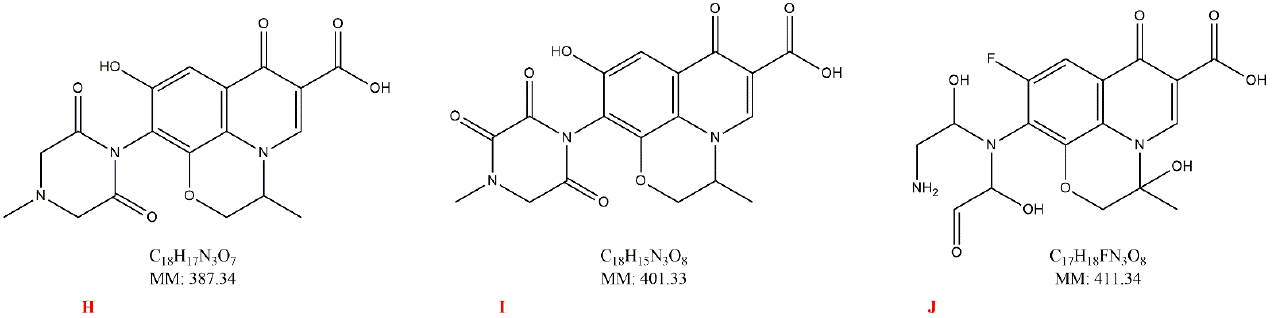
Figure 7. Proposed formulas for intermediates H – J .